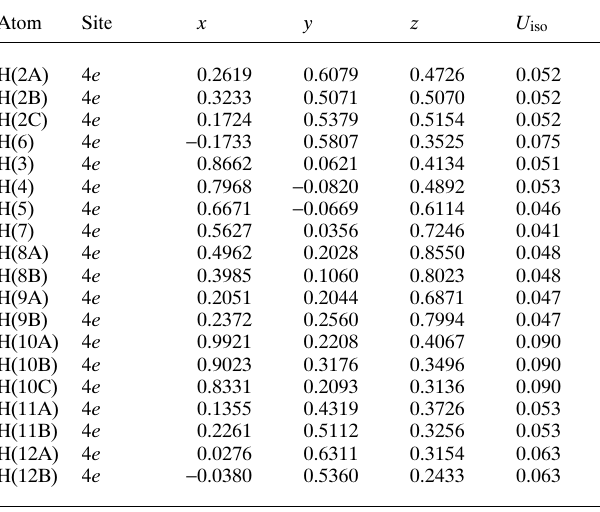
Table 2. Atomic coordinates and displacement parameters (in Å 2 )